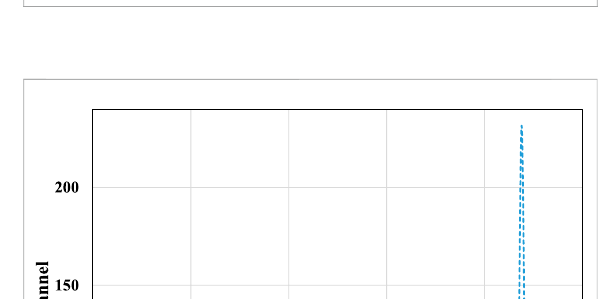
FIGURE 15 Axial linear heat power distribution of return channel considering different Reynolds numbers and heat power.